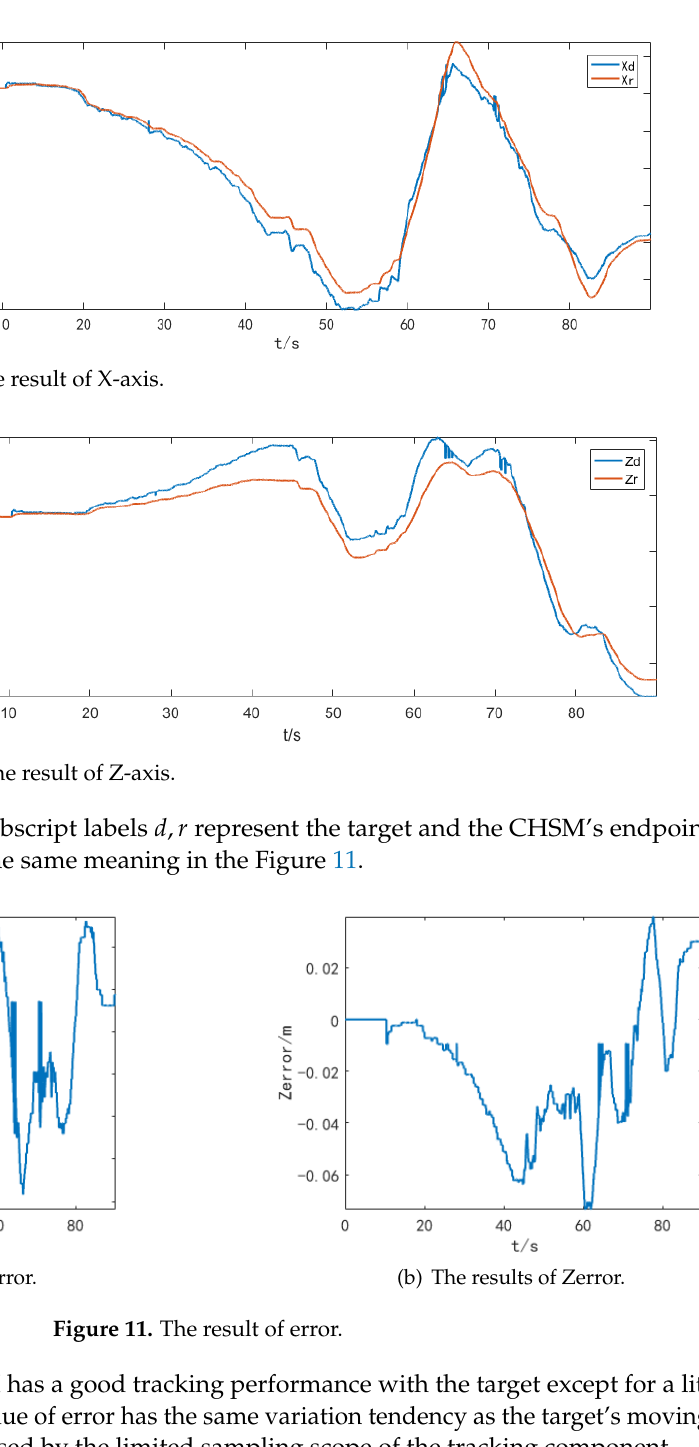
Figure 11. Camera’s FOV.